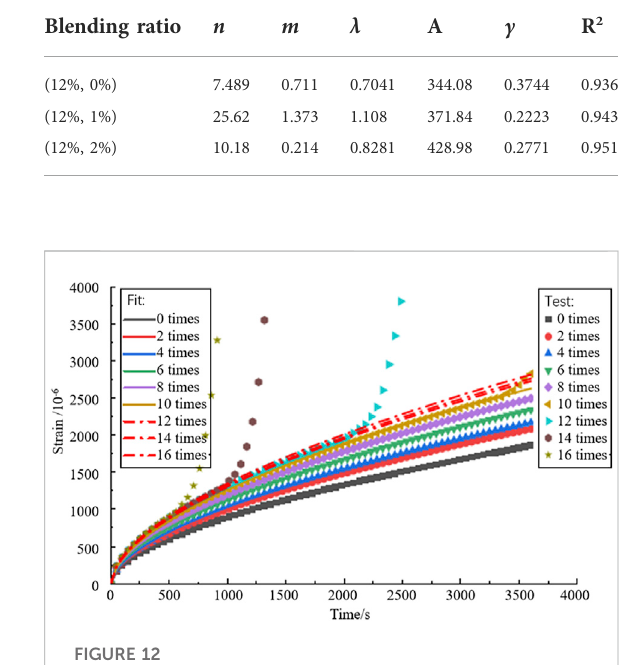
FIGURE 12 Creep fi tting curve of composite modi fi ed OGFC freeze- thaw damage at mixing ratios of